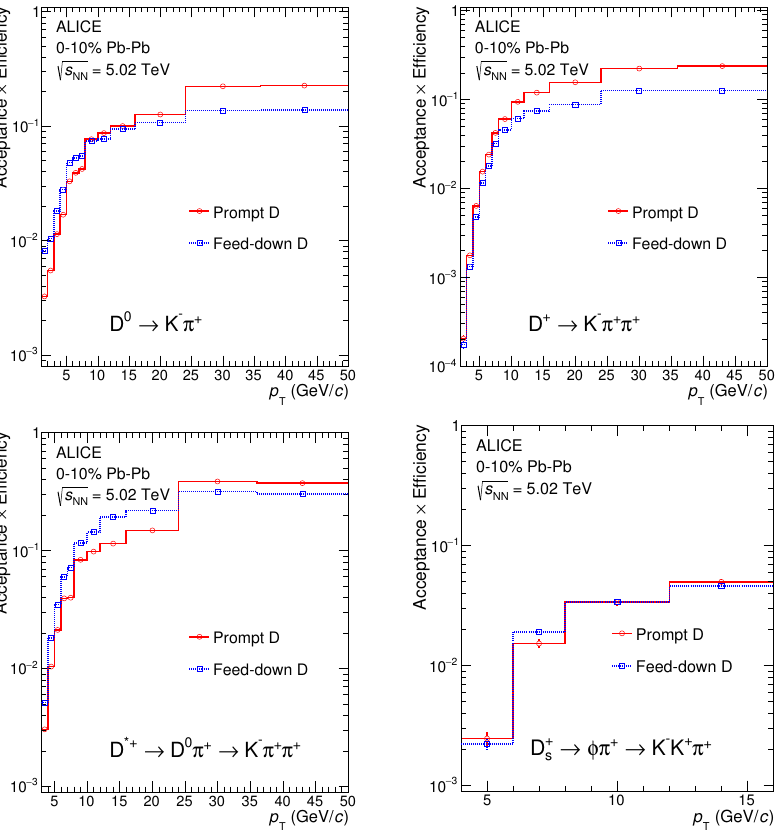
Figure 2 . Product of acceptance and e(cid:14)ciency as a function of p T for prompt (red circles) and feed-down (blue squares) D mesons in Pb{Pb collisions for the 0{10% centrality class obtained from MC